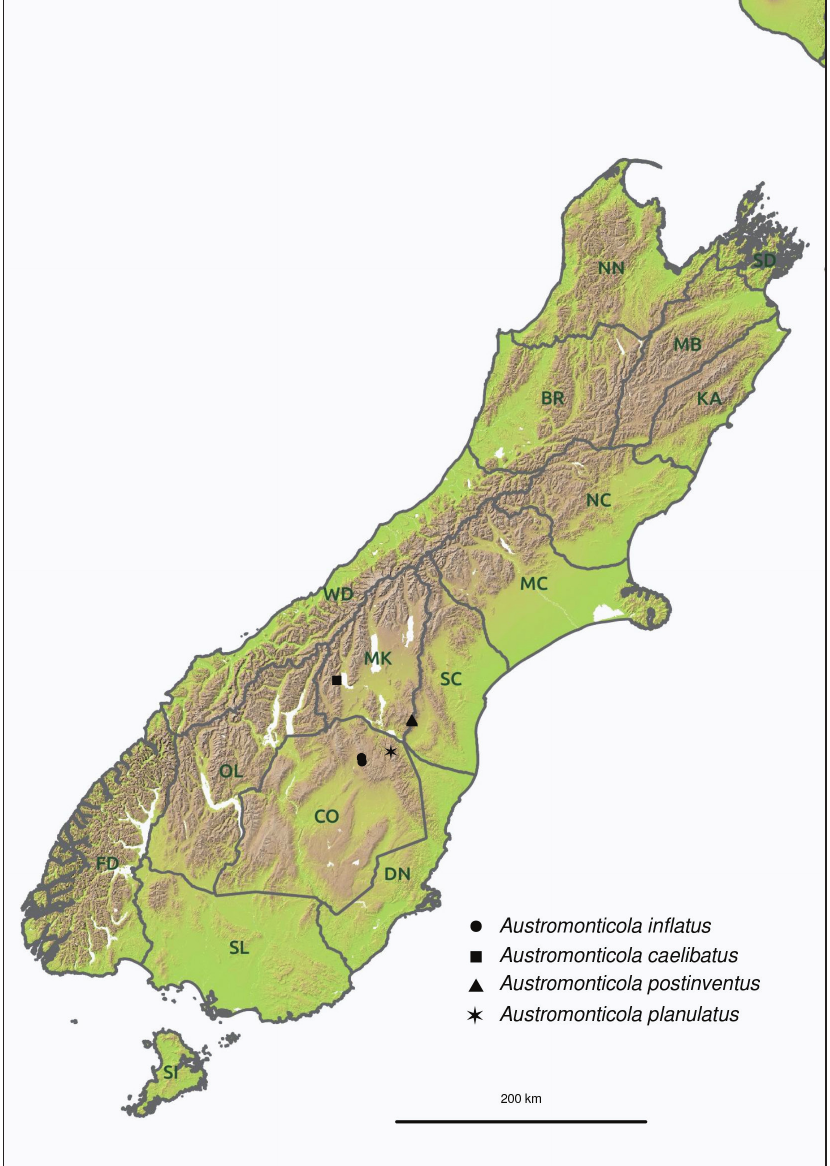
Figure 115. Distributions of Austromonticola inflatus (circles), A. caelibatus (squares), A. postinventus (triangles) and A. planulatus